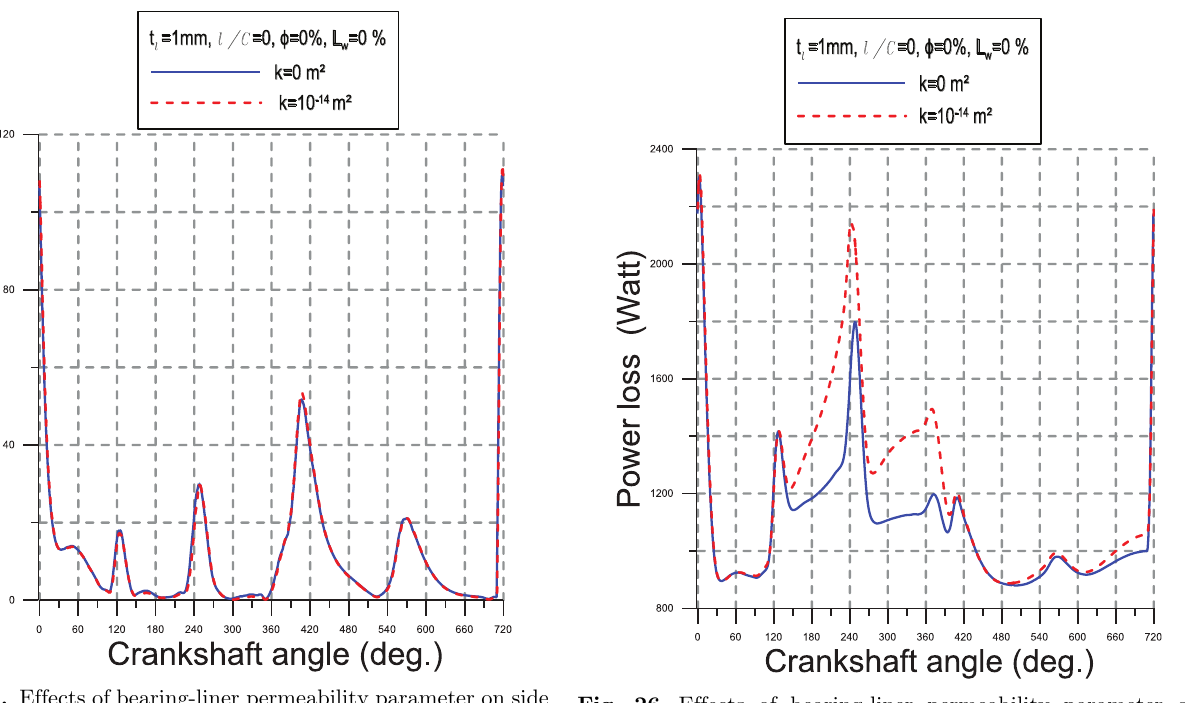
Fig. 26. Effects of bearing-liner permeability parameter on power loss over entire